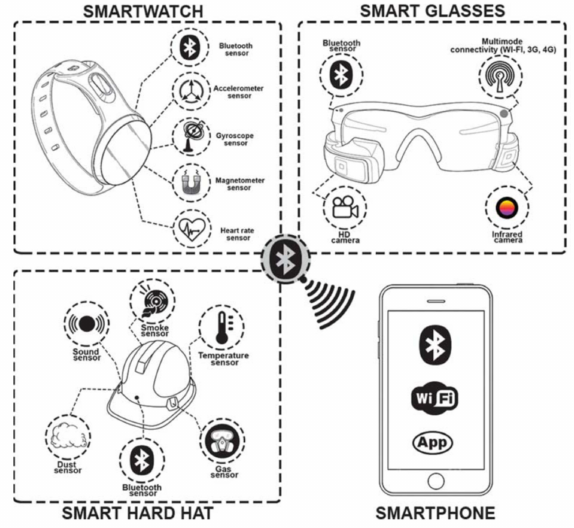
Figure 8. Smart technology and sensors attached in PPE